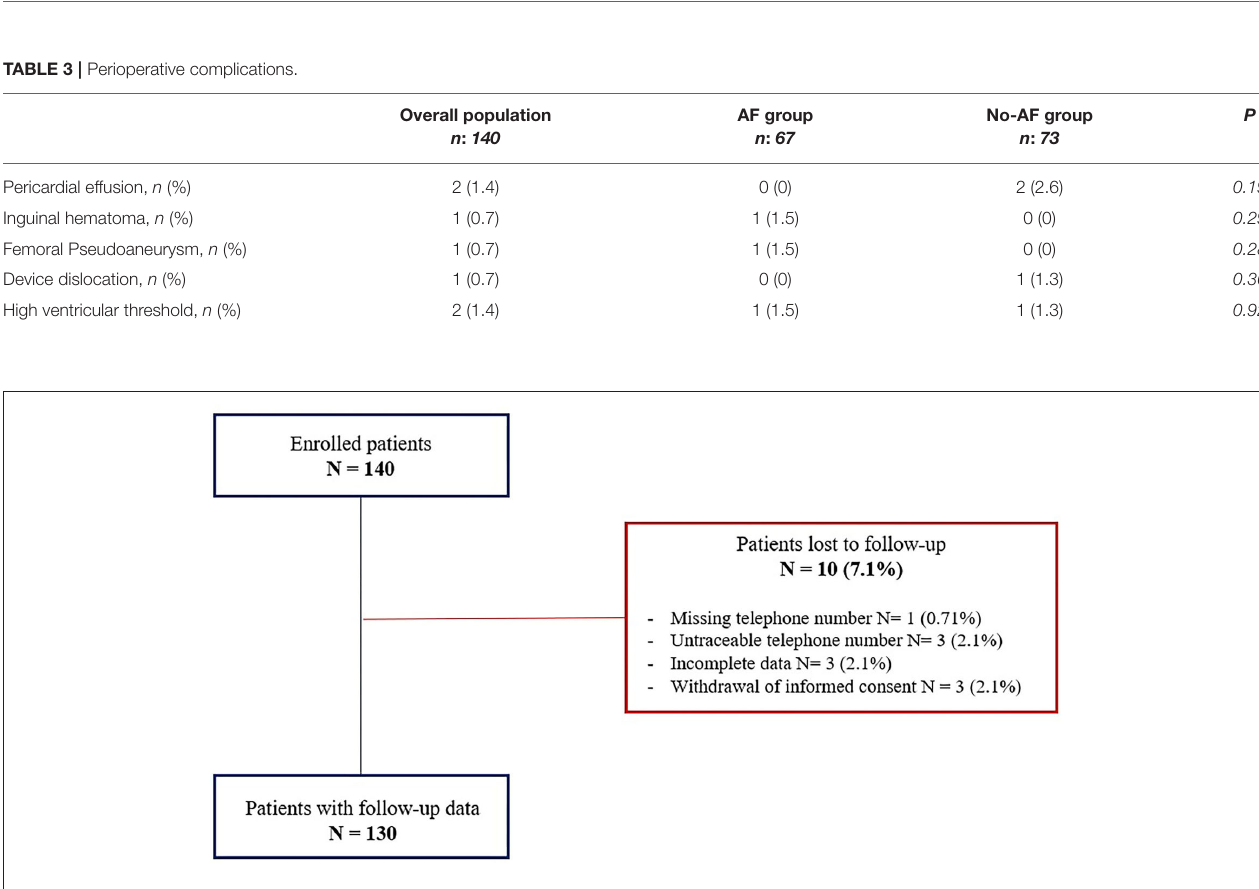
FIGURE 1 | Study of the